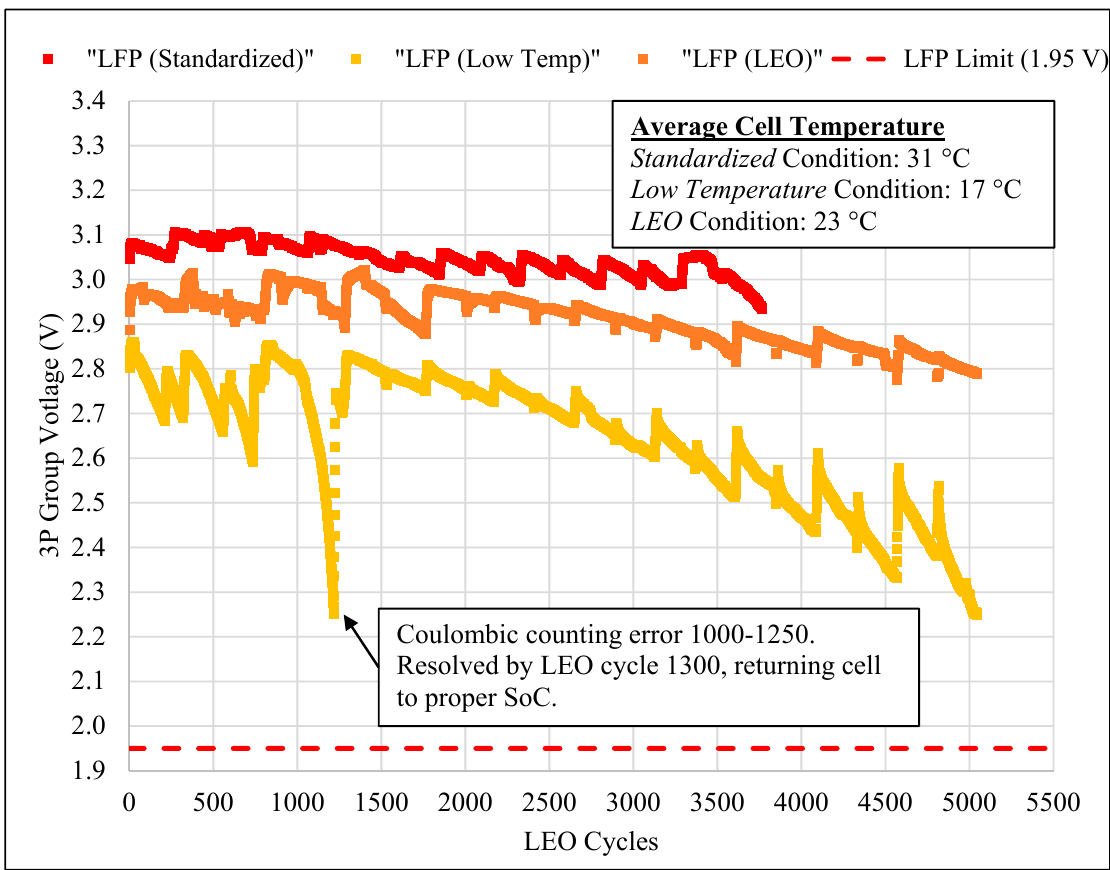
Figure 5. LEO cycling end of discharge voltage versus completed LEO cycles for LFP cells in all three conditions.